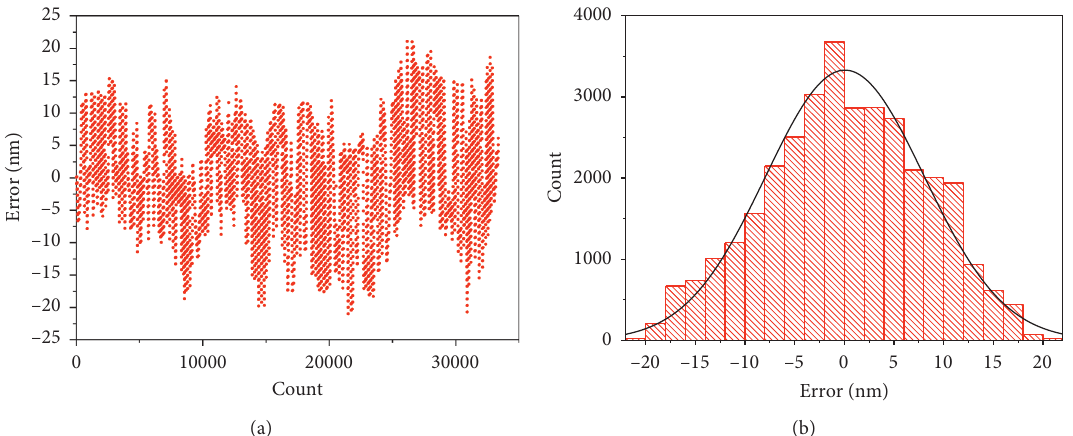
Figure 12: Stability curve of displacement sensor. (a) Scatter plot of displacement sensor stability. (b) Normal distribution the corresponding location samples, and Figure 12(b) is the corresponding normal curve distribution. By calculation, the standard deviation of the normal distribution curve is 8.9 nm.